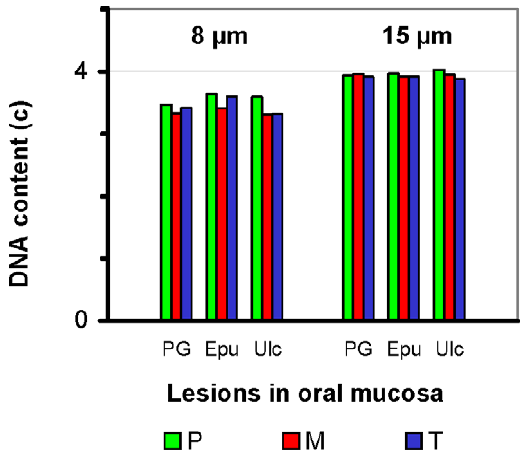
Fig. 2. Depth requirements for mitotic divisions as seen from 8 µ m and 15 µ m sections. Feulgen stained specimens from oral